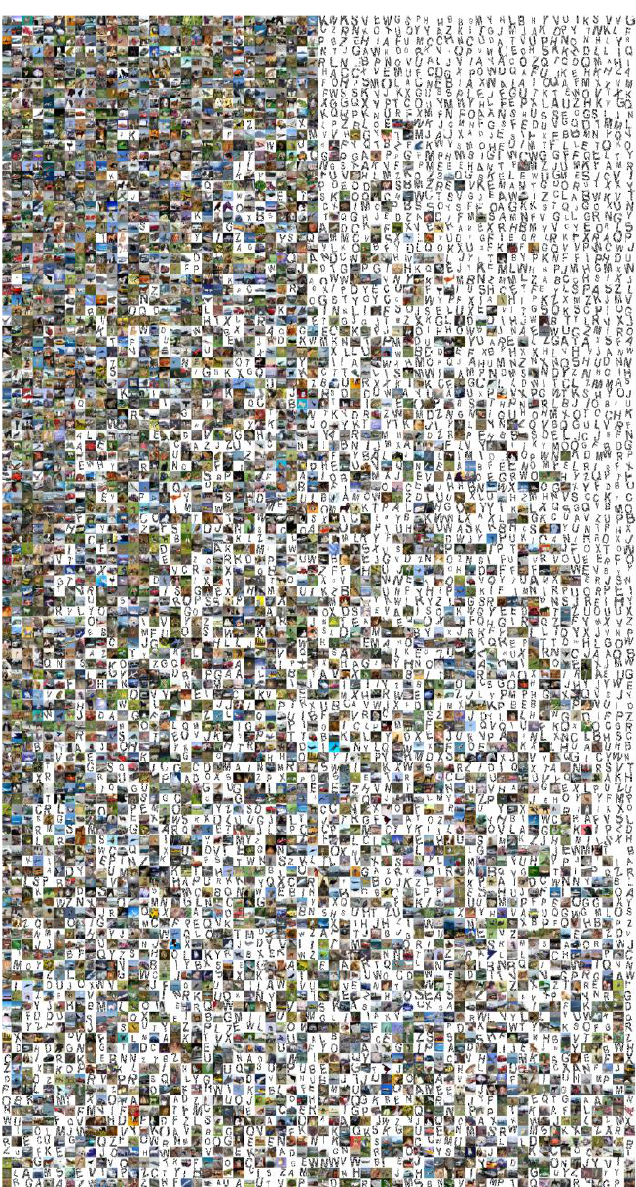
Fig. 3. Generalization and spreading of the appropriateness of a property by an example of CIFAR-10 and EEACL26 datasets. Images of the datasets and their unlike properties are progressively intertwined, appearing more “noisy” (descending from above). This can be thought of as a more complex